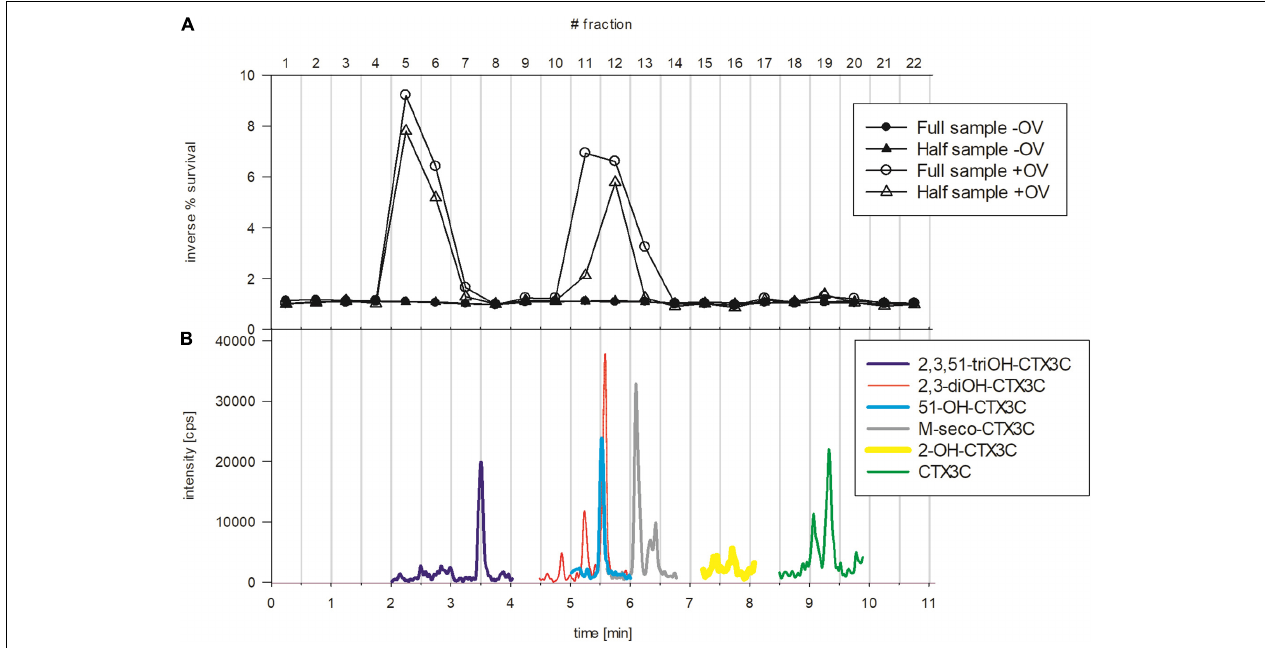
FIGURE 6 | (A) Bioassay-guided fractionation using the extract of sample #21 with fractions showing CTX-like toxicity in the N2a-3-(4,5-dimethylthiazol-2-yl)-2,5-diphenyltetrazolium bromide (MTT) assay. The assay was performed with fractions collected according to Section “Fractionation method,” the circle and triangle represent undiluted and 1:2 diluted samples, respectively. The black symbols correspond to control wells (–OV) and open symbols correspond to +OV conditions (0.22/0.022 mM O/V) (see legend of Figure 4A for details). (B) LC-MS/MS analysis of sample extract #21 (non-fractionated) with Extracted Ion Chromatograms of potential CTX congeners detected in the sample. The colored lines represent the m/z of the sodium adducts of 2,3,51-trihydroxyCTX3C (dark blue, min 2-4), 2,3-dihydroxyCTX3C (red, min 4.5-6), 51-hydroxyCTX3C (light blue, min 5-6), M- seco -CTX3C (gray, min 6–6.45), 2-hydroxyCTX3C (bold yellow min 7.2–8.1), and CTX3C (green, min 8.5–9.8); OH, hydroxy. Vertical lines indicate the collection period of the fractions during bioassay-guided